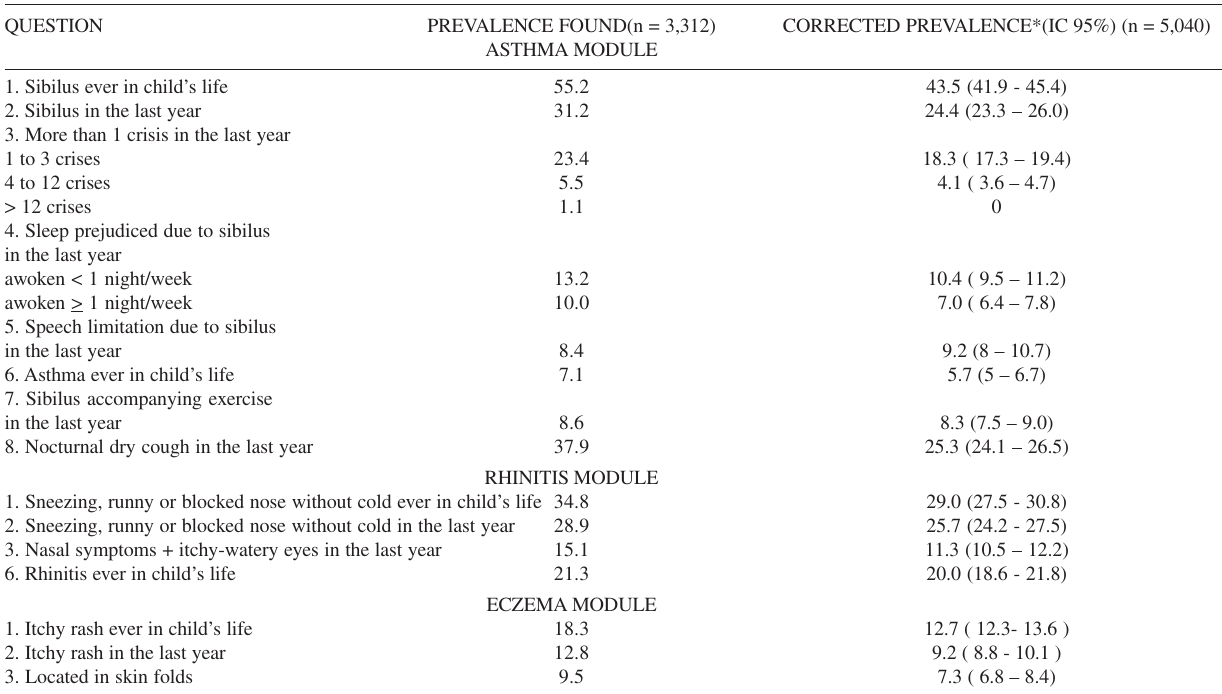
Table 4. Comparison of the asthma , rhinits and eczema (%) symptom prevalences found and corrected in 3,312 6-7 year- old students from the western districts of São Paulo City